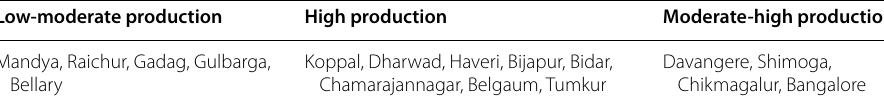
Table 1 Results of PAM algorithm